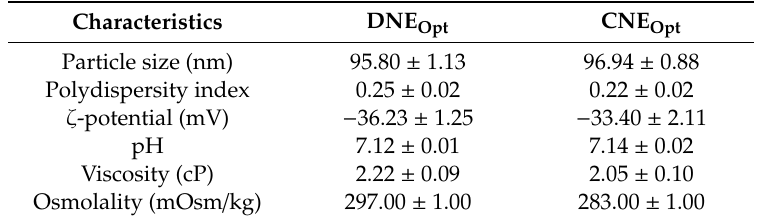
Table 4. Physicochemical characteristics of the optimized formulations.